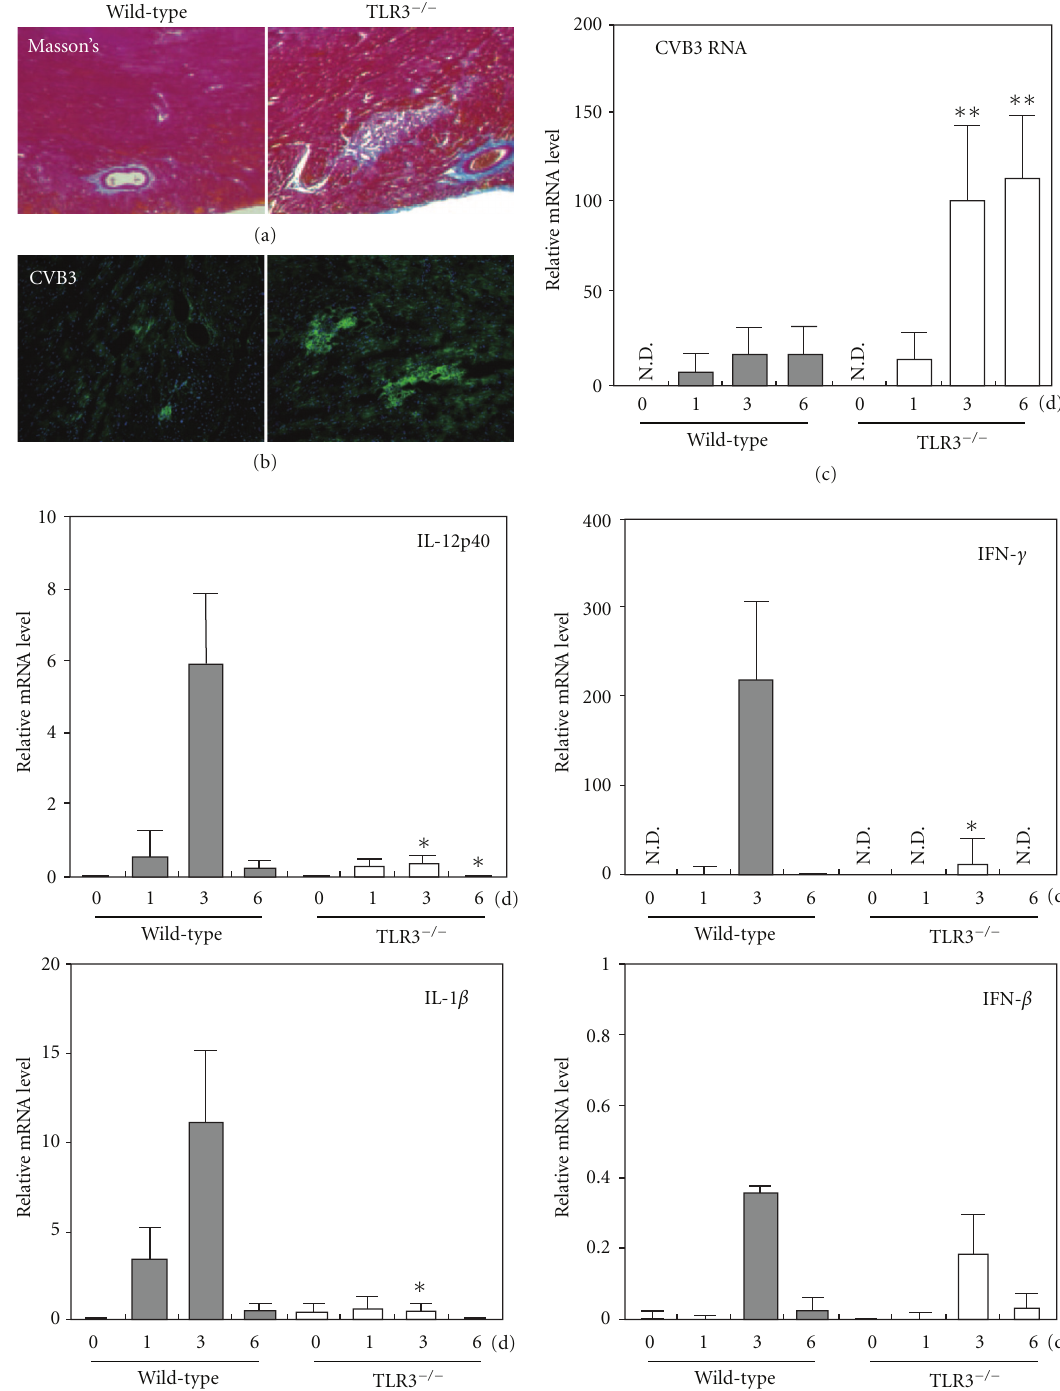
Figure 5: Myocarditis in TLR3 − / − mice infected with CVB3. (a) Histopathologic results of hearts collected from TLR3 − / − and wild-type mice 12 days after CVB3 infection was evaluated with Masson’s trichrome staining. Data represent eight mice per group. (b) Immunofluorescence of hearts from TLR3 − / − or wild-type mice 9 days after CVB3 infection followed by anti-CVB3 antibody staining. Data represent three mice per group. (c),(d) Real-time RT-PCR analysisof the expression of positive-strand CVB3 RNA (c) or the indicated cytokine genes (d) in hearts of TLR3 − / − and wild-type mice on the indicated days after CVB3 infection. Data are presented as mean ± SD of triplicate determinations. All experiments were performed more than twice with similar results. ∗∗ P < 0 . 01; ∗ P < 0 . 05. (Negishi et al . , [108], used with